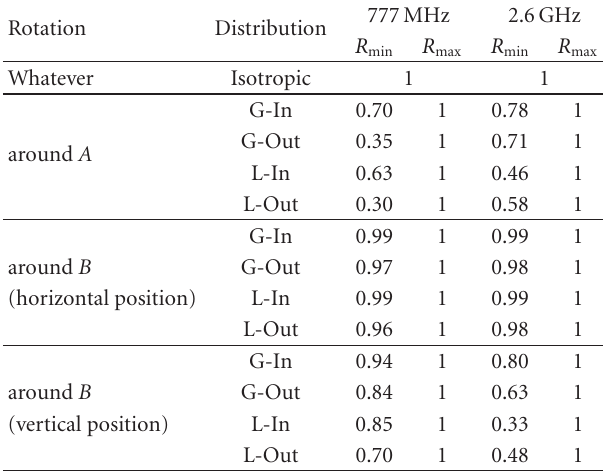
Table 2: MEG ratio ( R ) for the two bands for all environments of the proposed structure.